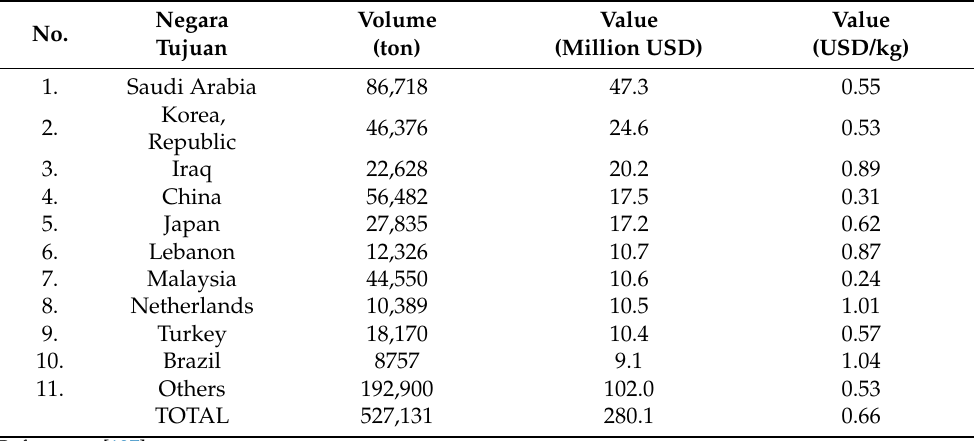
Table 8. Top ten countries for Indonesia’s charcoal export destination